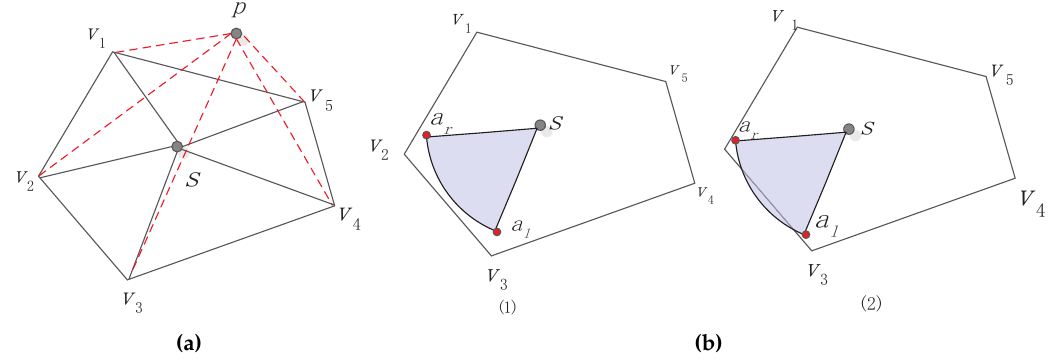
Figure 3. Proof point in convex polygon and sector wrapped in convex polygon. ( a ) Point in polygon; ( b ) sector wrapped in convex